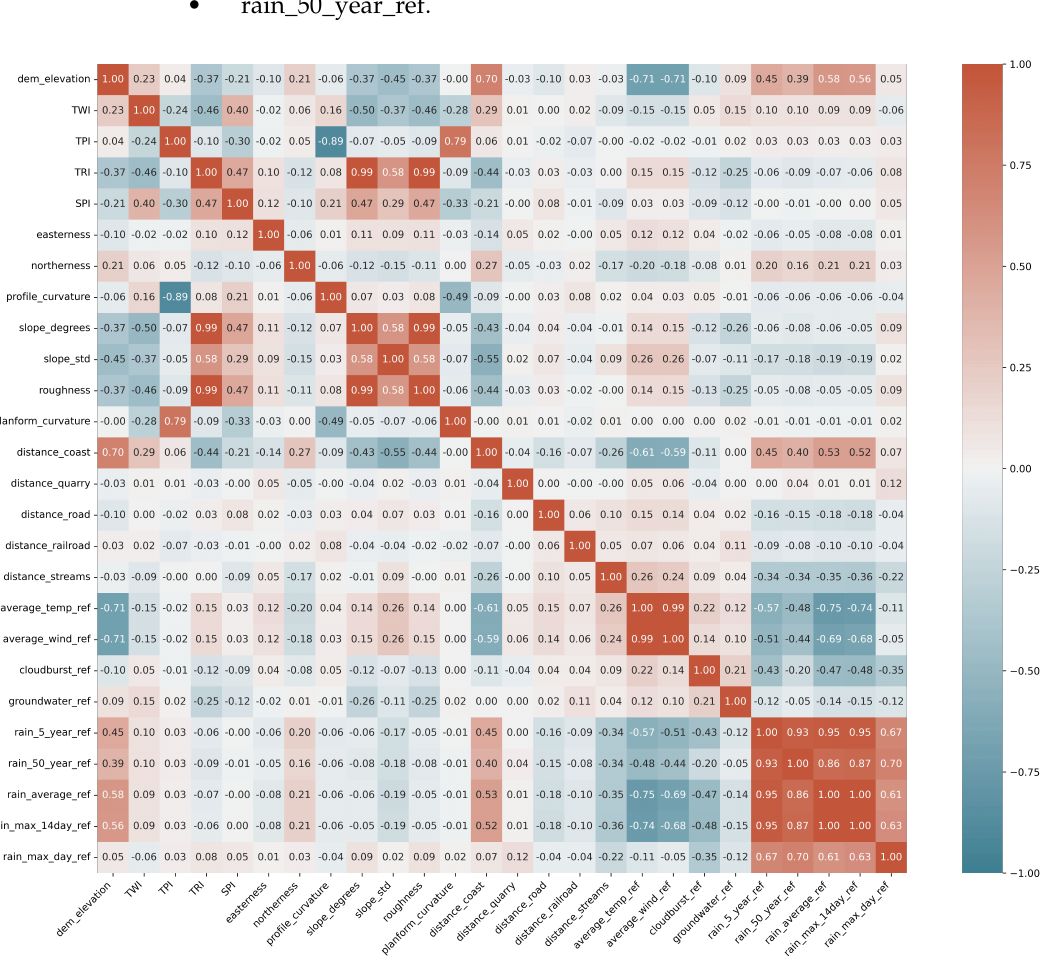
Figure 5. Matrix with the Pearson correlation between the predictive